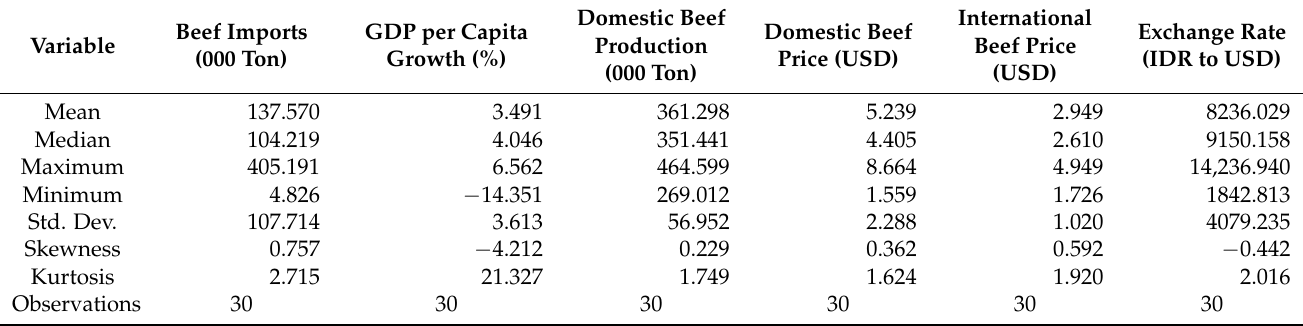
Table 2. The descriptive statistics of the variables for the time period of 1990–2019.